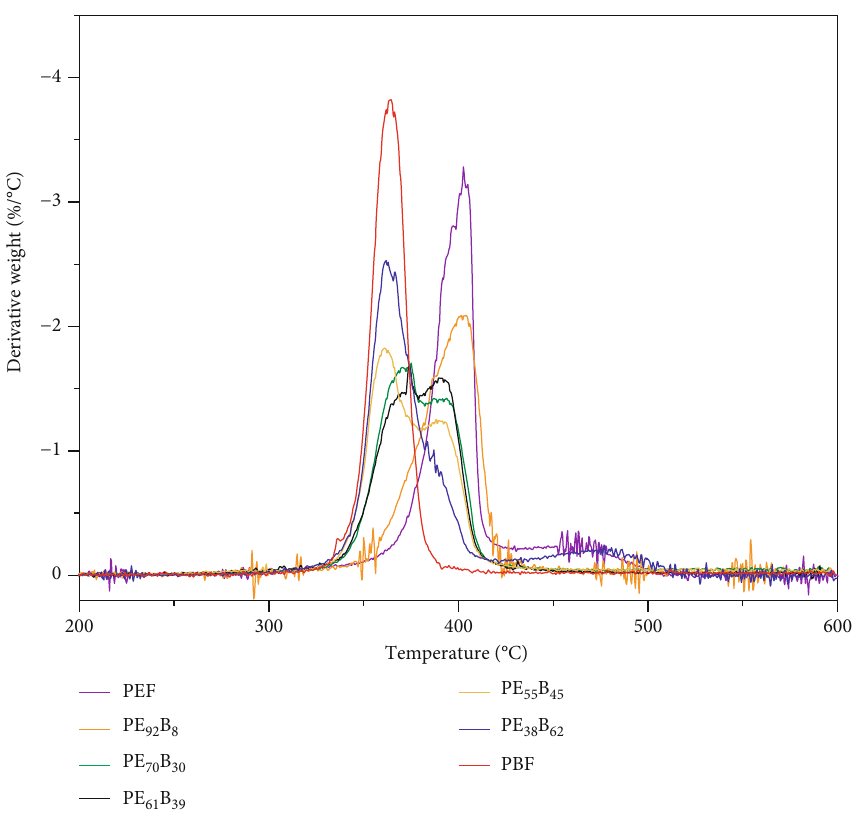
Figure 6: DTGA plots of PEF, PBF, and